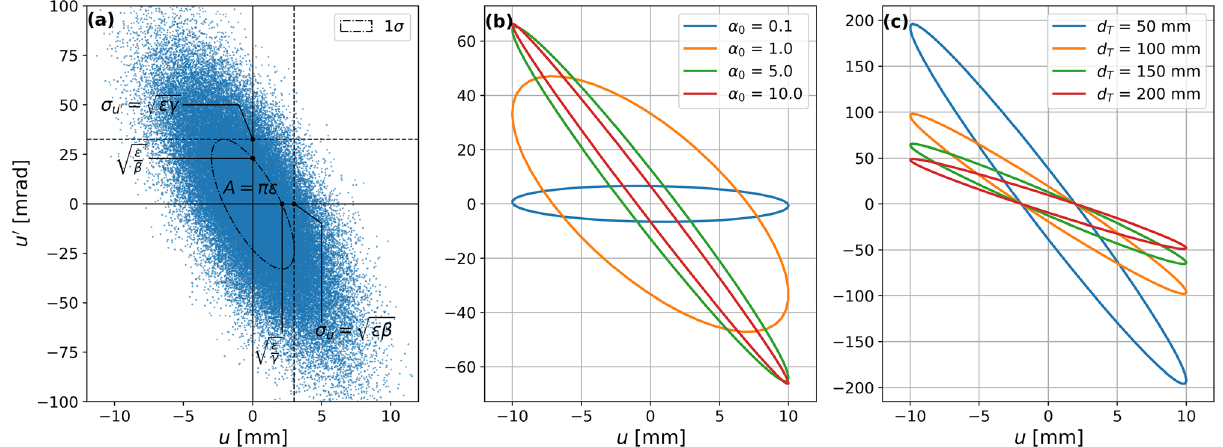
Figure 2. The phase space diagram represents the distribution of the beam’s particles. ( a ) The Twiss parameters α , β , γ , and ǫ describe the Gaussian distribution of the phase-space coordinates u and u ′ of the particles at a given position along the beam line. The ellipse indicates the 1 σ boundary of the distribution. ( b ) Phase space 10 mm . ( c ) Phase space 150 mm , and σ 0 ellipse for α 0 = 0.1, 1.0, 5.0, and 10.0, at a target distance d T = = 5.0 and σ 0 10 mm for target distance 50 mm, 100 mm, 150 mm, and ellipses for focused beams with α 0 = = 200